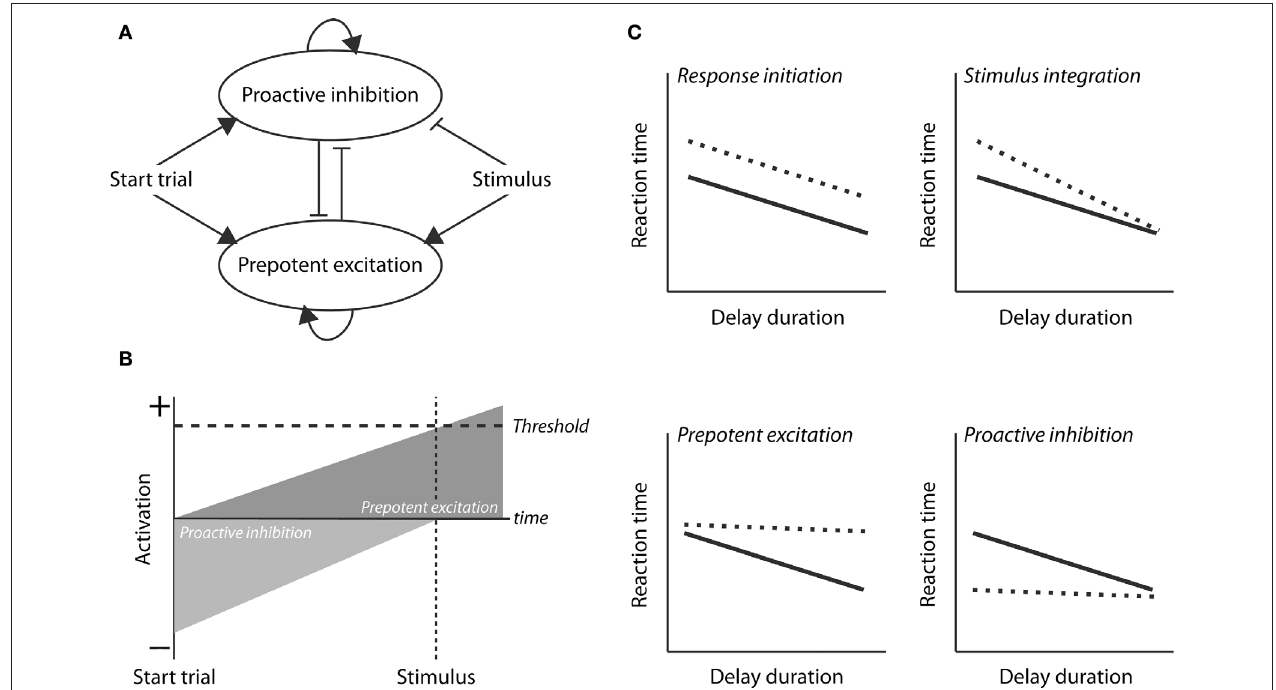
FIgure 1 | Conceptual model for control of simple rT performance. (A) A neural circuit model for top–down control of action (based on Jaffard et al., 2008 and Narayanan and Laubach, 2009). Two control processes are active during the delay period. Proactive inhibition serves to limit inappropriate responding until the stimulus is delivered. prepotent excitation serves to increase the level of activation in the motor system. The difference between these processes serves as an Activation function and responses are initiated if this function is greater than the threshold. (B) Time-course of the proactive inhibition and